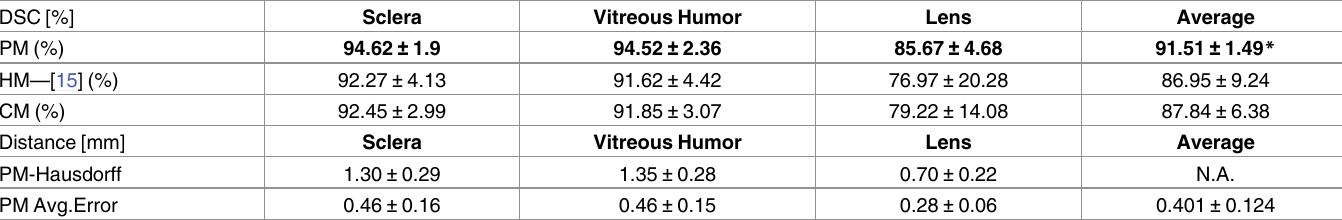
Table 1. Eye anatomy DSC: Our Pathological Model (PM) shows more accurate results than the Healthy Model (HM) from [15] and the Combined Model (CM), especially for the region of the lens. ( * ) p < 0.05. The table indicatesboth the Dice Similarity Coefficient (DSC) and the maximum surface seg- mentationerror or Hausdorff Distance (HD) , in mm.